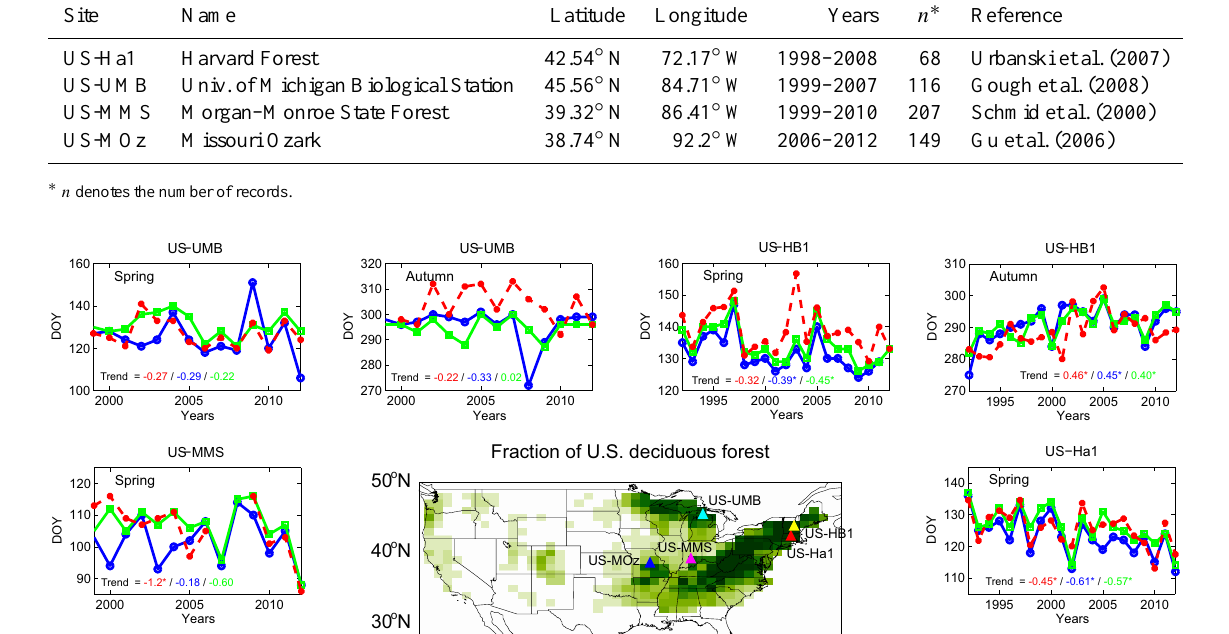
Table 2. Ground measurements of leaf area index (LAI) used to calibrate the phenology model. The location of these sites is denoted on Fig. 1. Site Name Latitude Longitude Years n ∗